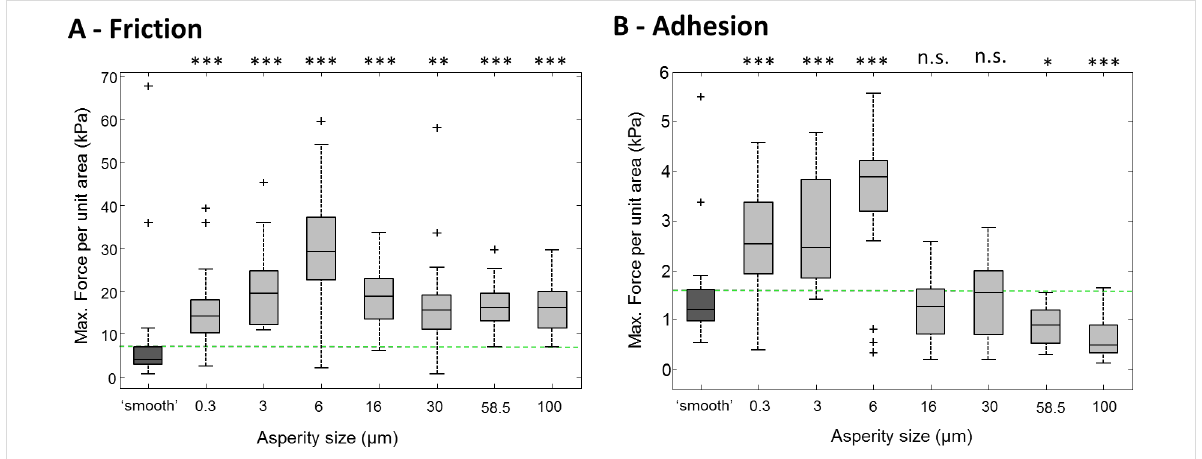
Figure 2: Single toe pad forces on rough surface replicates. Force per unit area has been calculated for friction (graph A) and for adhesion (graph B). Performances on surfaces of varying roughness (approximate asperity heights) are compared with ‘smooth’ surface performance (dark grey box, left). The green dashed lines show mean values on the smooth surface to aid comparisons. Statistical tests are denoted above each box (due to the Bonferroni correction: 95% confidence interval p = 0.0071 (*), 99% p = 0.0014 (**), 99.9% p = 0.00014 (***), and n.s. = not significant).